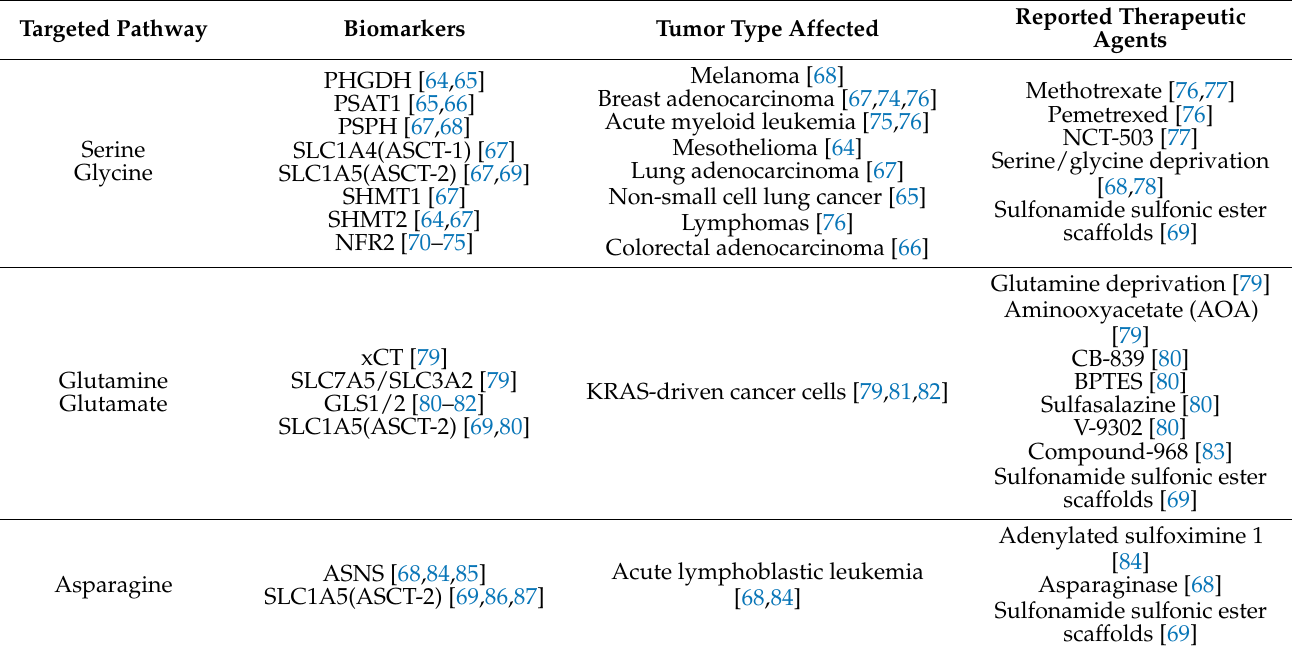
Table 2. Protein metabolic alterations in